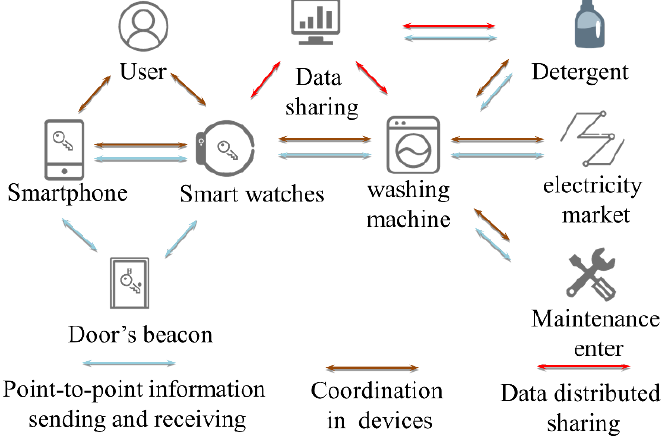
Figure 10. Application scenarios of the autonomous decentralized peer-to-peer telemetry (ADEPT) system.